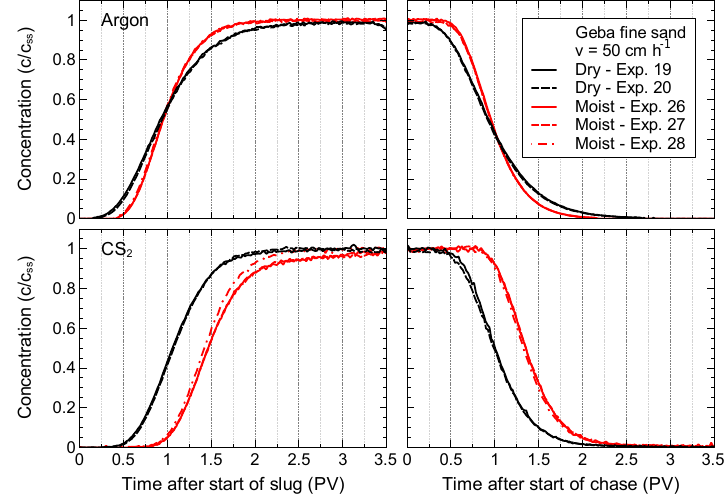
Figure 7. Breakthrough curves of CS 2 and Ar in dry and moist ( S w = 0.154) Geba fine sand under identical slug and flow conditions ( v = 50cmh − 1 ).